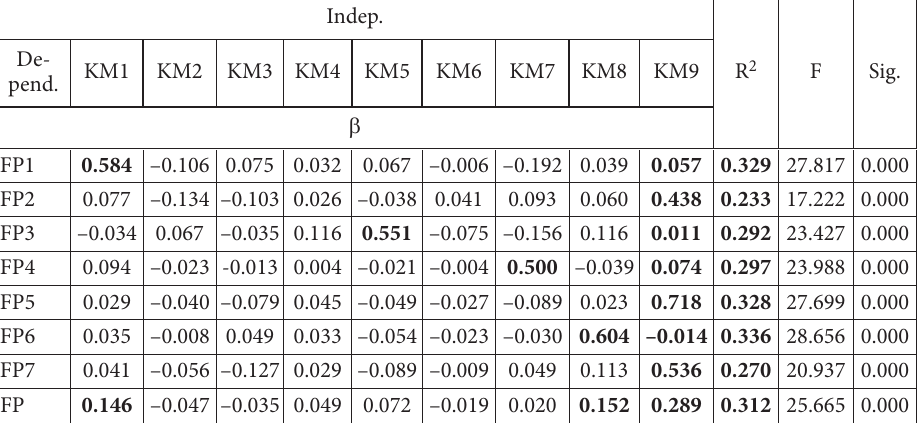
Table 2. Regression analysis (independent variables: the knowledge management dimensions; depen- dent variables: the financial performance items and the financial performance dimension) Indep. Sig.De- R 2 F KM1 pend.